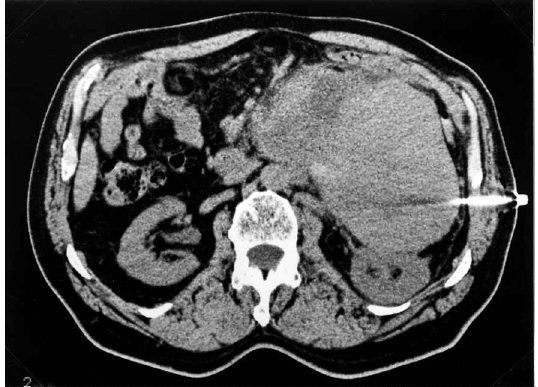
Fig. 1. Partially necrotic retroperitoneal leiomyosarcoma at computed tomography-guided